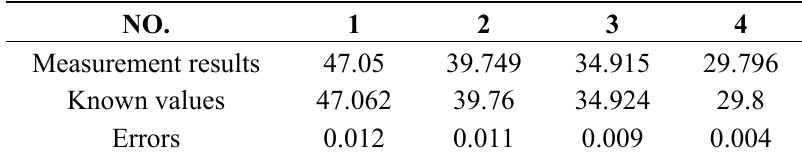
Figure 11. Images of stripes by camera: ( a ) shaft 1; ( b ) shaft 2. Table 3. Measurement results for shaft 1 (mm).